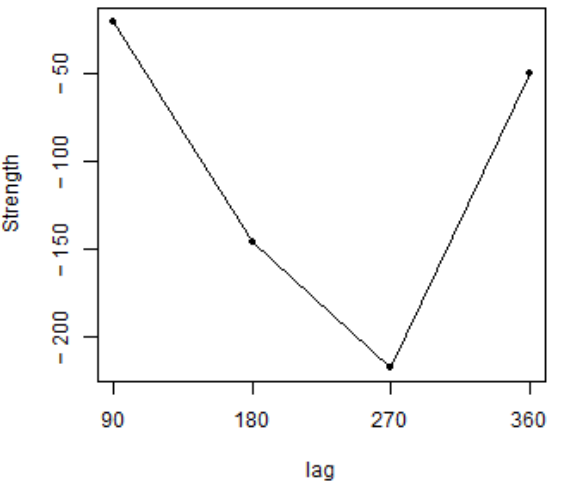
Figure 6. Social media data vs. official statistics: strength of the arc from the quality of job ( wor ) and the unemployment rate with different data